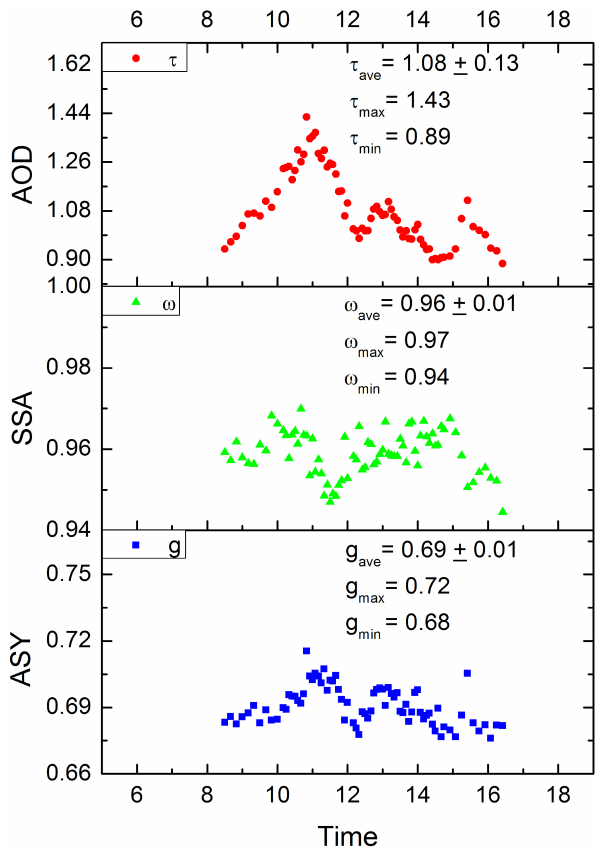
Figure 4. The same as Fig. 1 but for a day with large diurnal changes of aerosol loading under highly polluted (AOD equals to 1.08 in average) weather conditions on 12 February 2008.